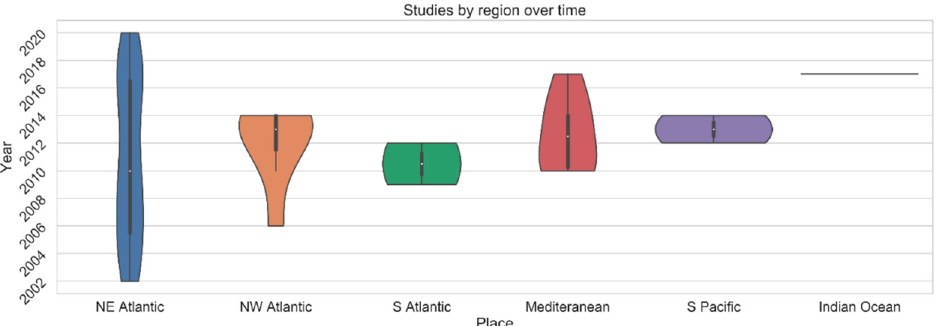
Figure 2. Violin plot visualizing the studies whose primary methods utilize spatial mapping and processing of CWC habitats since 2002.